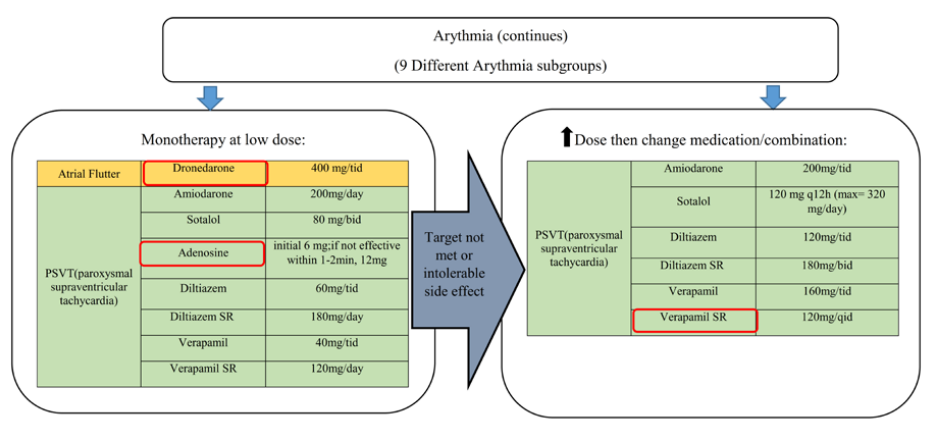
Figure 2C. The different medication therapy scenarios in arythmia.